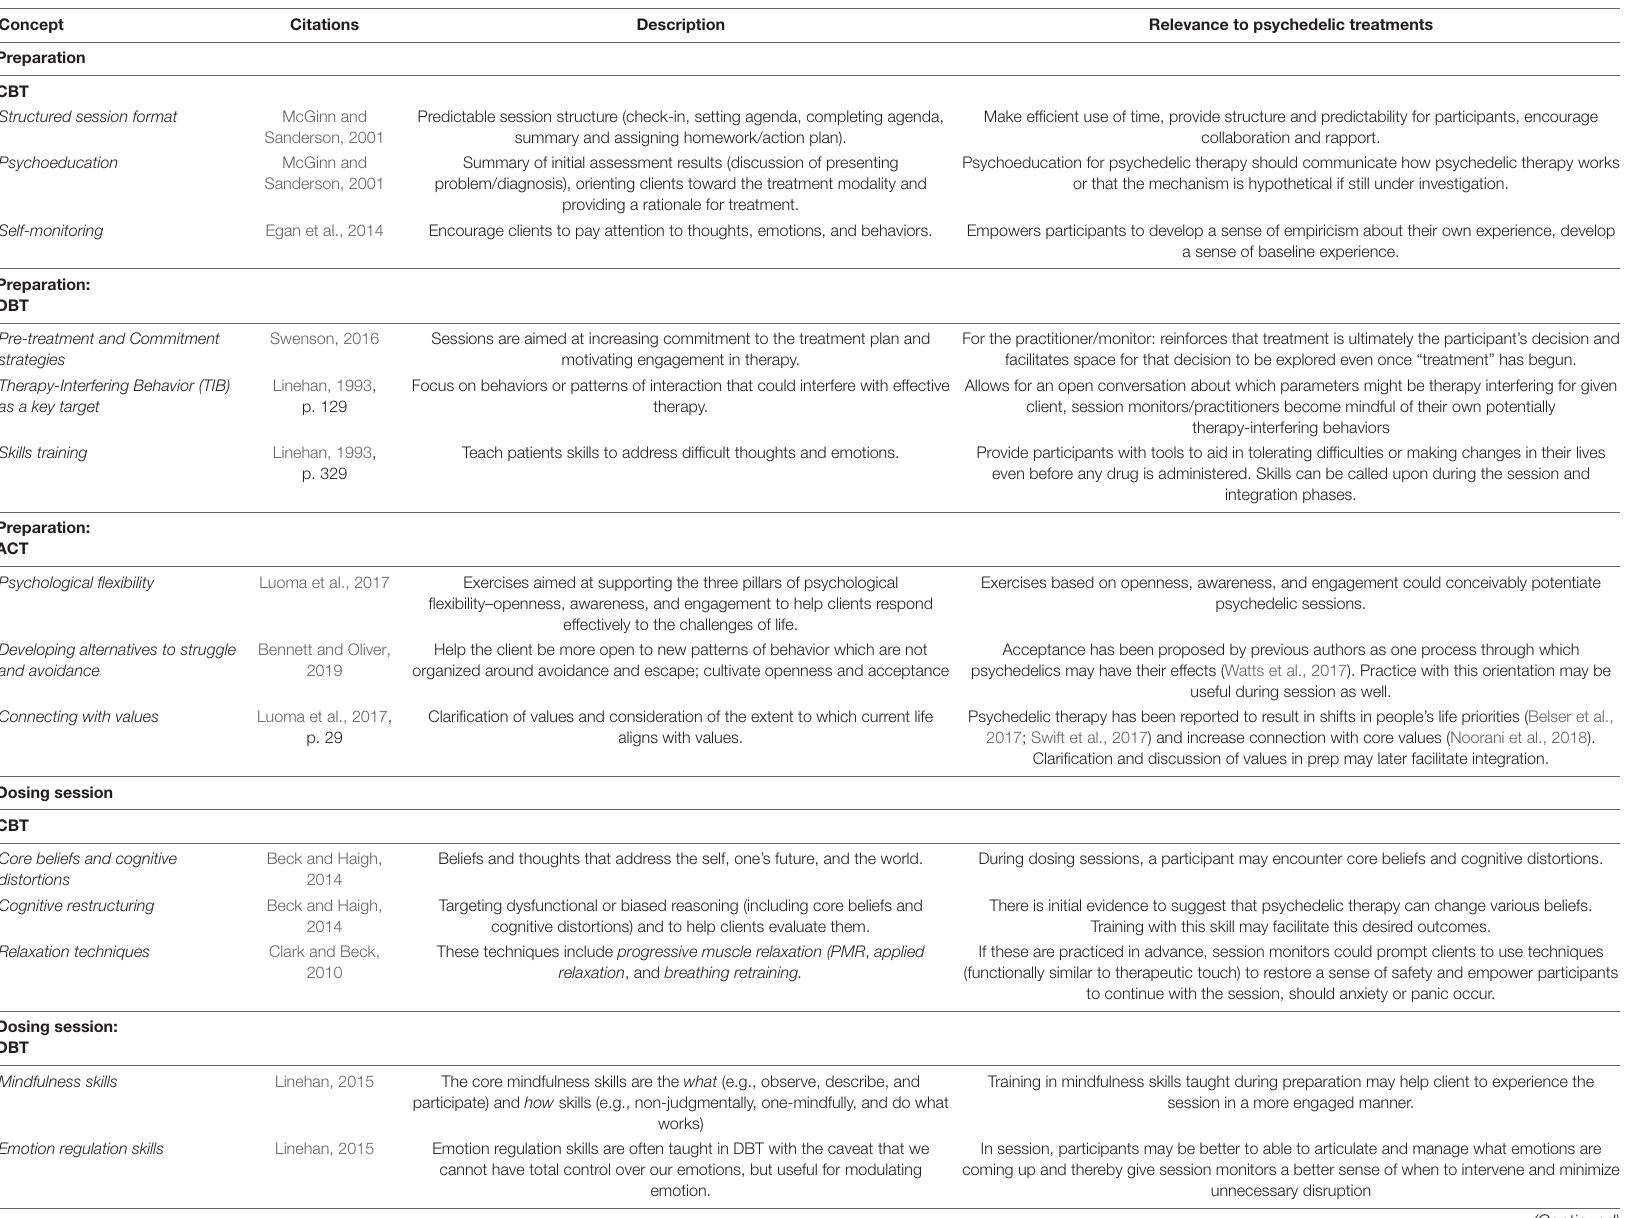
TABLE 1 | Concepts from cognitive-behavioral approaches relevant to psychedelic treatments, by therapy phase (preparation, dosing session, integration). Concept Citations Description Relevance to psychedelic